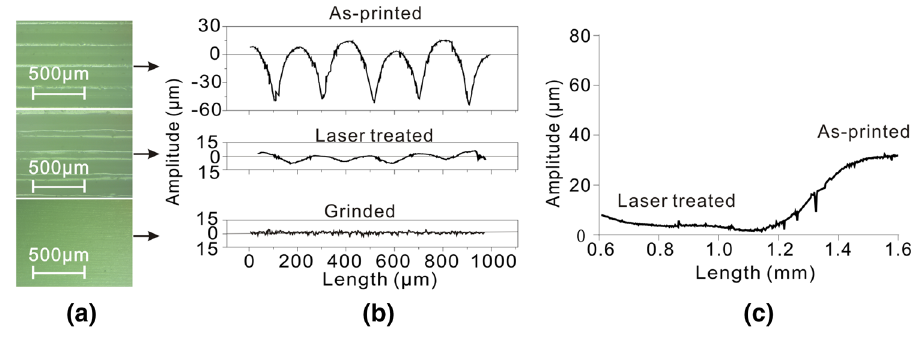
Fig. 2 Surface profile. a surface roughness, images taken from inverted microscope; b Quantitative measurement of surface waviness of 3D printed samples under different post treatment; c Surface profile of the peak of a layer